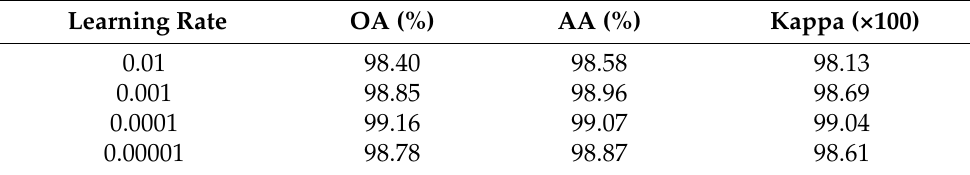
Table 7. Comparison experiments with different learning rates on the IP dataset.